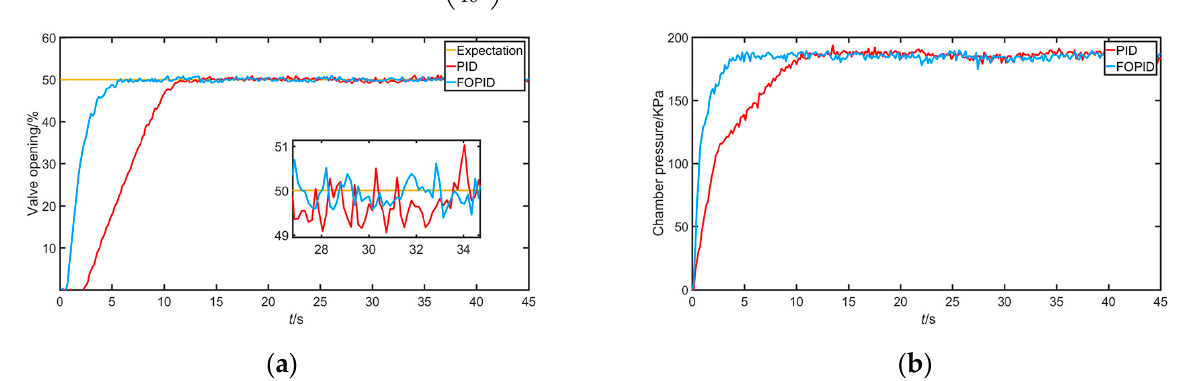
Figure 18. ( a ) Response signal under 50% valve position opening tracking; ( b ) error of response signal under 50% valve position opening tracking. Table 4. The corresponding performance indicators of the two algorithms at 50% opening. Performance Indicators